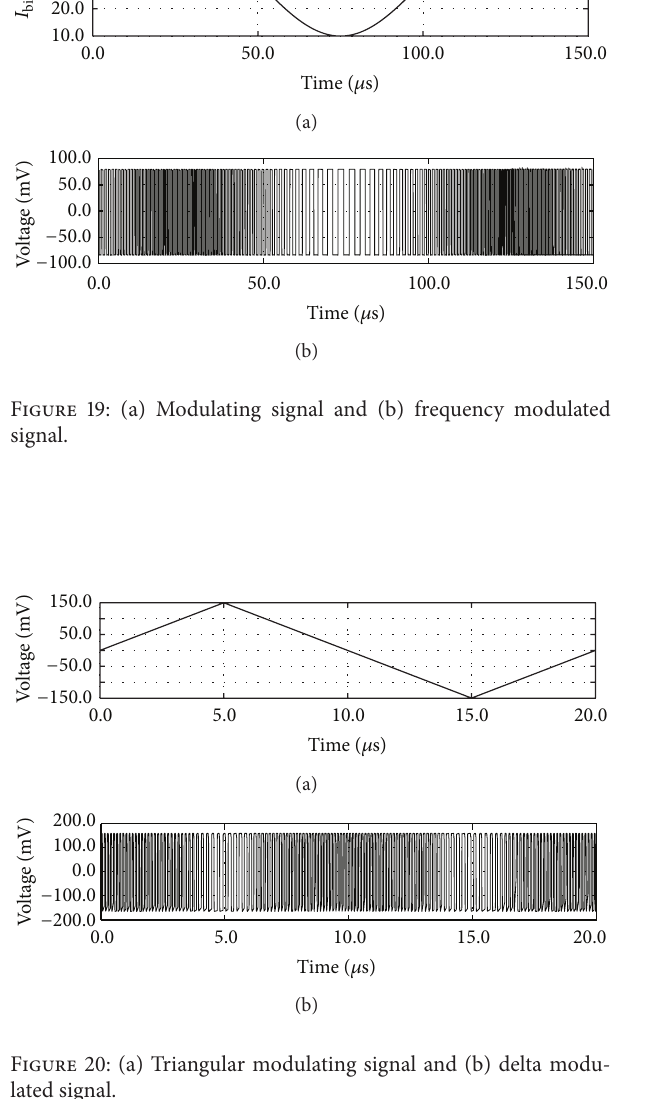
Figure 22: (a) Triangular modulating signal and (b) sigma delta modulated